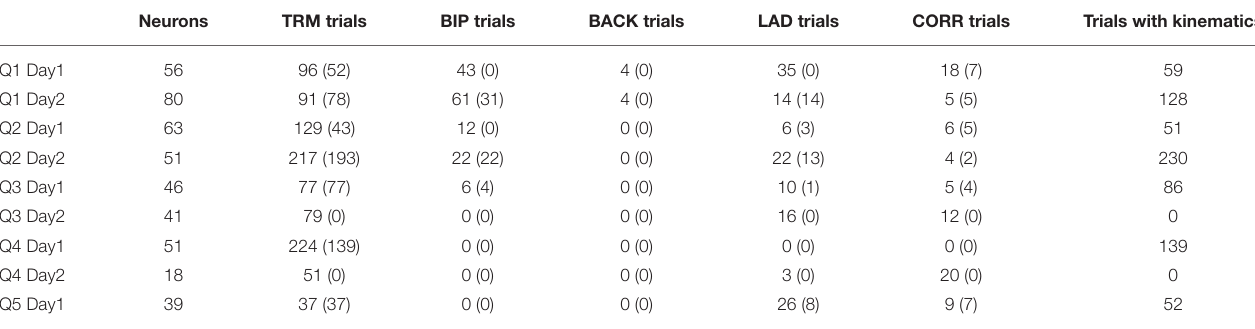
TABLE 1 | Number of trials and neurons recorded for each recording day of each animal. Neurons TRM trials BIP trials BACK trials LAD trials CORR trials Trials with kinematics